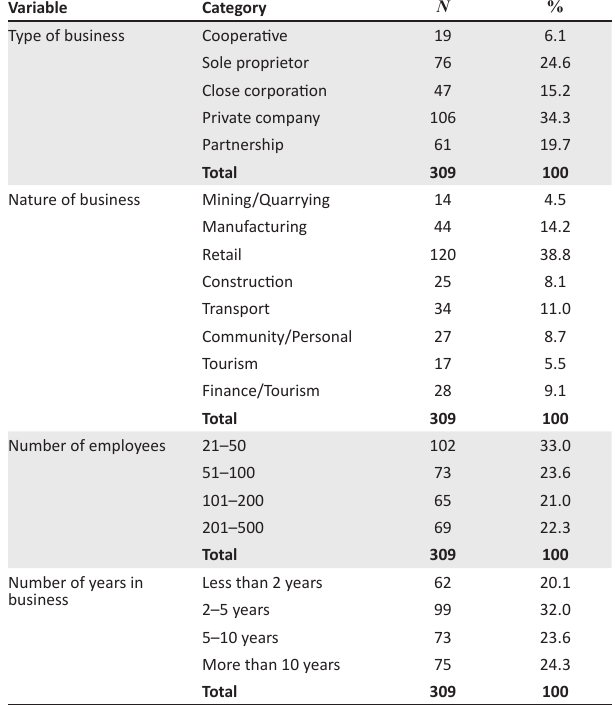
TABLE 1: Profile of small to medium